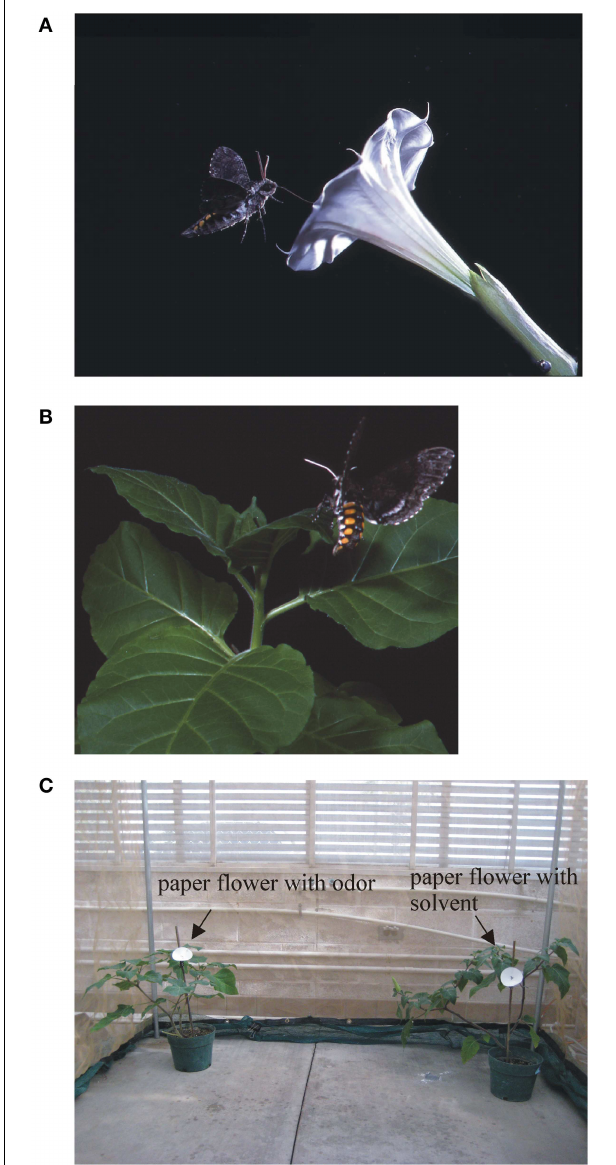
FIGURE 1 | (A) Adult M. sexta feeding on nectar from a flower from one of its favorite host plants, the jimsonweed Datura wrightii . (B) Females also use this plant as an oviposition resource (Picture by C. Hedgcock). (C) Experimental set-up used to study the oviposition behavior of females in the laboratory. Singly mated female are released in a flight cage in a dual-choice experiment. In this case, the insect is offered two plants, one with an artificial paper flower loaded with a synthetic odor (experimental) and the other loaded with the solvent